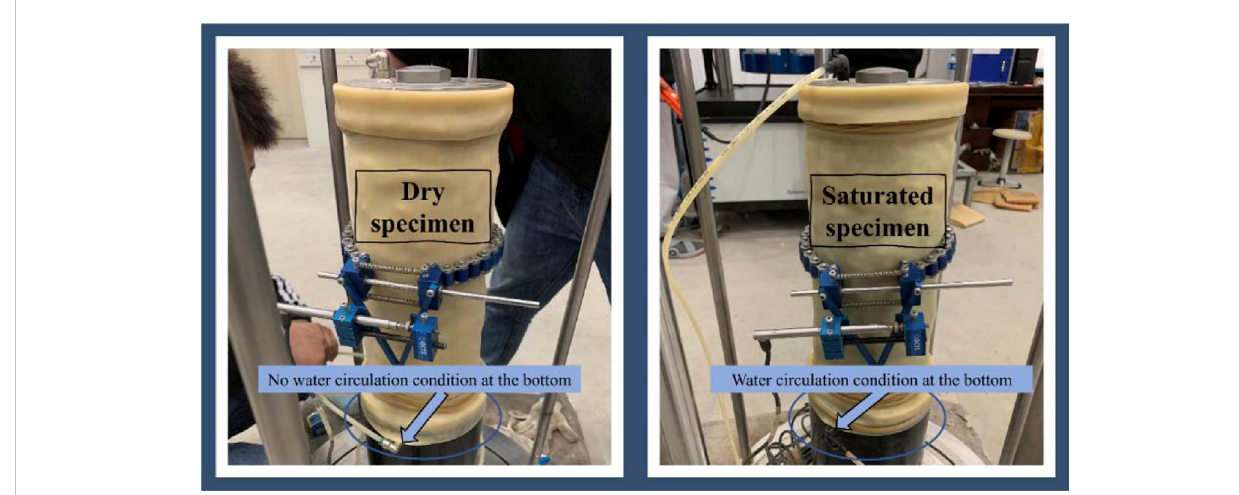
FIGURE 2 Comparison of dry and saturated specimens.